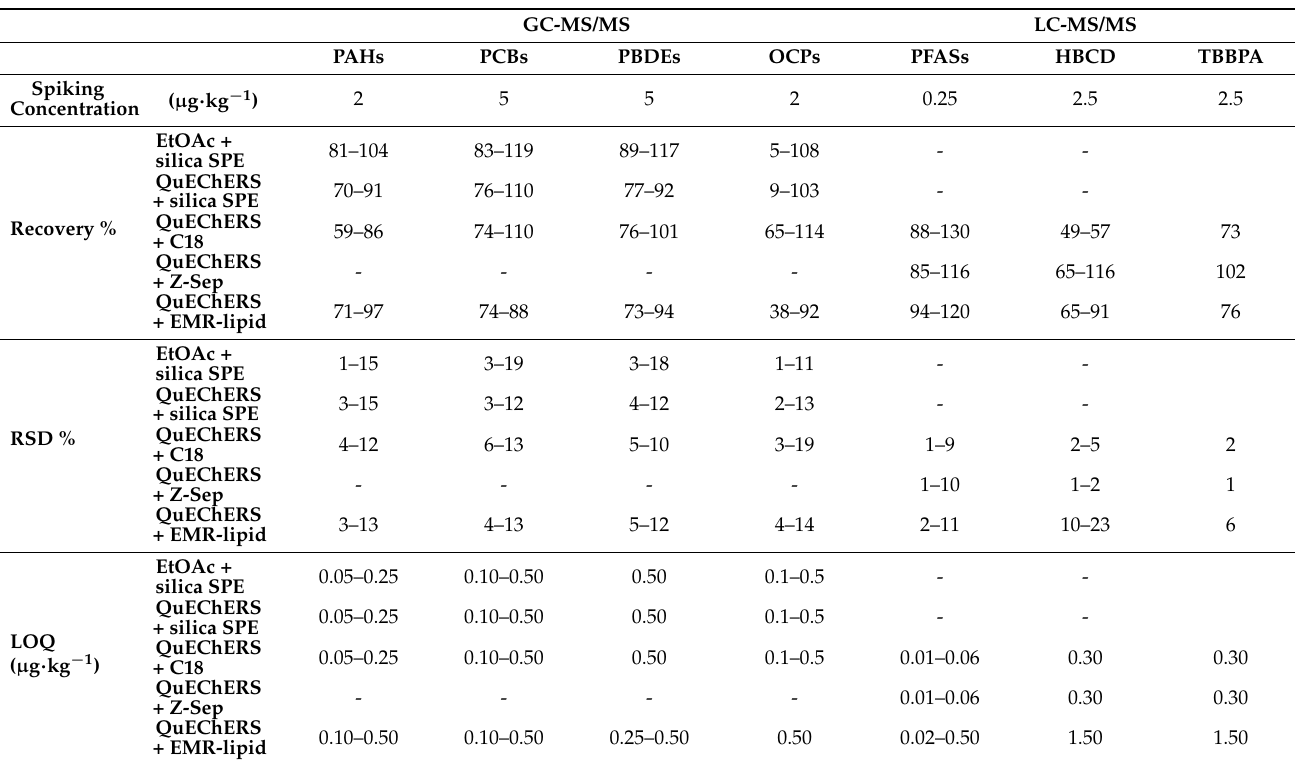
Table 1. Method performance characteristics obtained in the verification study (REC—recovery (%); RSD—repeatability (%); LOQ—limit of